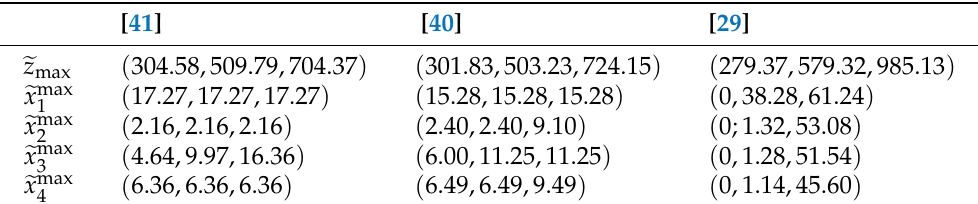
Table 2. Comparative numerical results for a full fuzzy LP